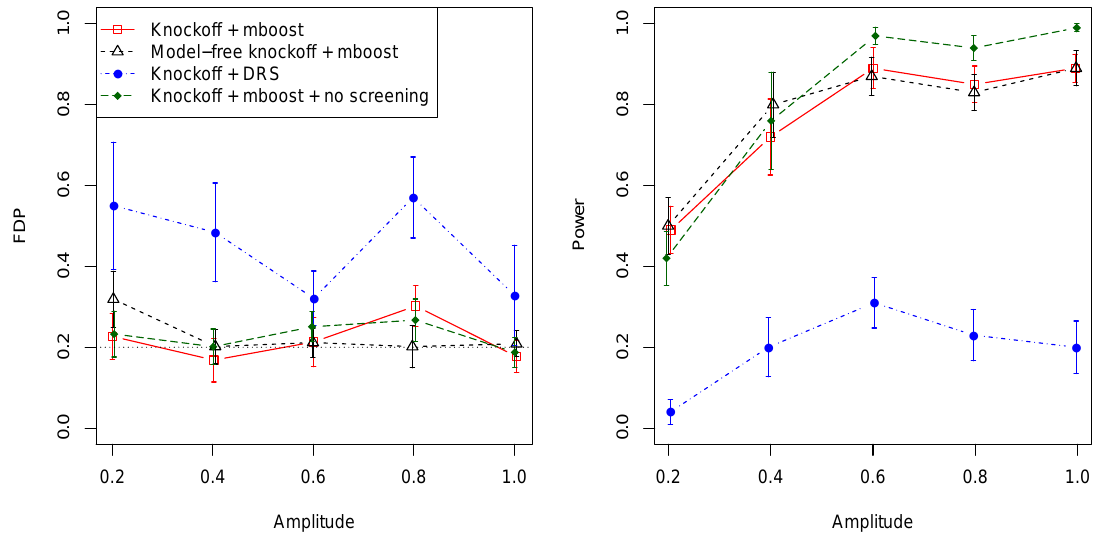
Figure A1. Simulation results for linear associations with log-normal covariates. Left panel: averaged false discovery proportion (FDP, the empirical version of FDR) and the standard error bars for knockoff variable selection with Knockoff with mboost (red), Model-free knockoff with mboost (black), Knockoff with DRS (blue) and Knockoff with mboost without screening (dark green) as a function of amplitude (association strength (e.g., correlation) between a biomarker and the outcome) based on 10 simulation replications. The reference lines indicate the target false discovery rate of 20%. Right panel: corresponding empirical statistical power of the four methods.